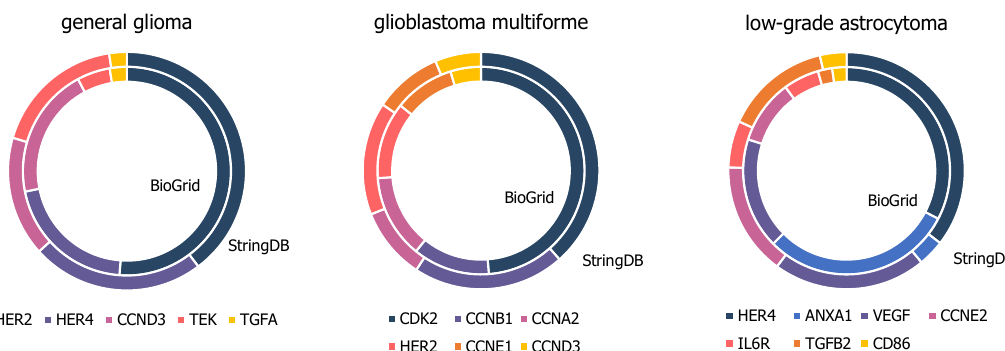
Figure 5. High-degree genes of general glioma, glioblastoma multiforme and low-grade astrocytoma samples, present in BioGrid and StringDB constructed networks upon top ten hubs.